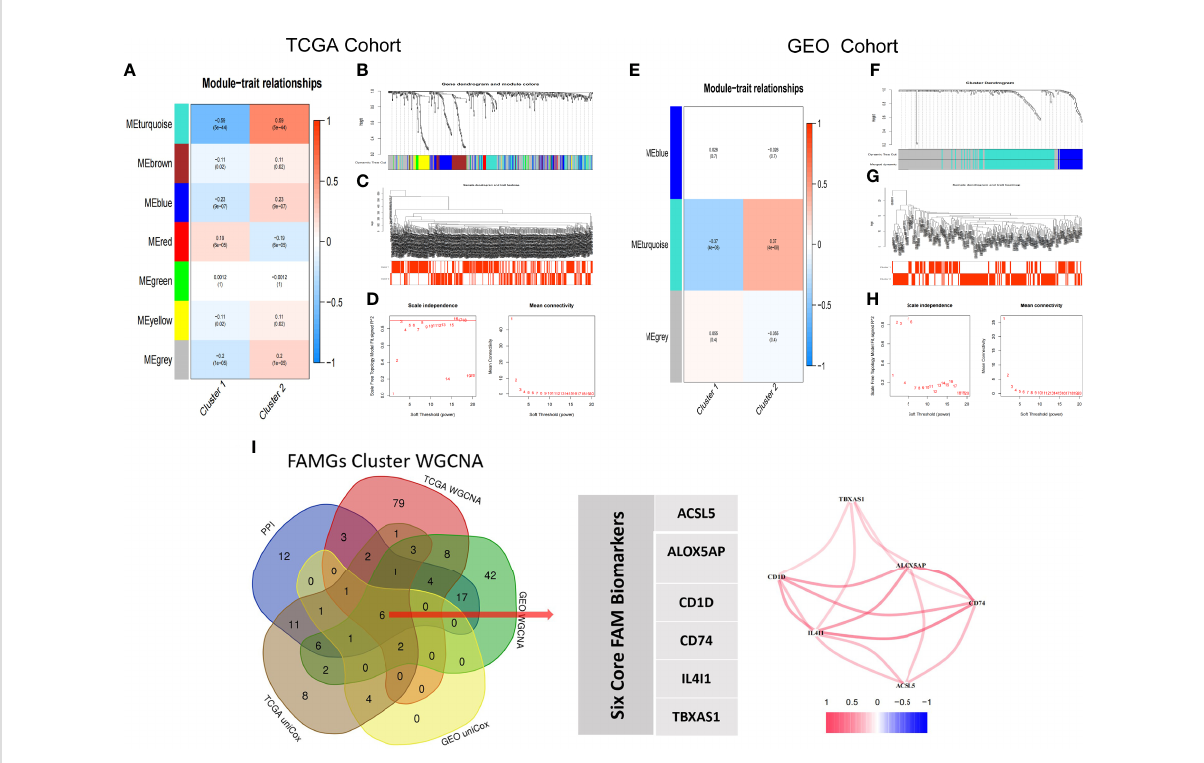
FIGURE 5 WGCNA-selected FAM molecular subtypes modules and genes. (A – D) TCGA Cohort WGCNA, (A) Seven modules are identi fi ed by WGCNA in TCGA samples; the turquoise module is highly correlation with FAM molecular subtypes (Cor= ± 0.59, p<0.001). (B) Dynamic Tree plot. (C) Sample heatmap of cluster 1 and cluster 2. (D) scale independence and mean connectivity. (E – H) Three modules are identi fi ed by WGCNA in GEO samples; the turquoise module is highly correlation with FAM molecular subtypes (Cor= ± 0.39, p<0.001). (I) Venn Diagram. ACSL5, ALOX5AP, CD1D, CD74, IL4I1 and TBXAS1 are identi fi ed as core biomarkers of FAM molecular subtype in CM